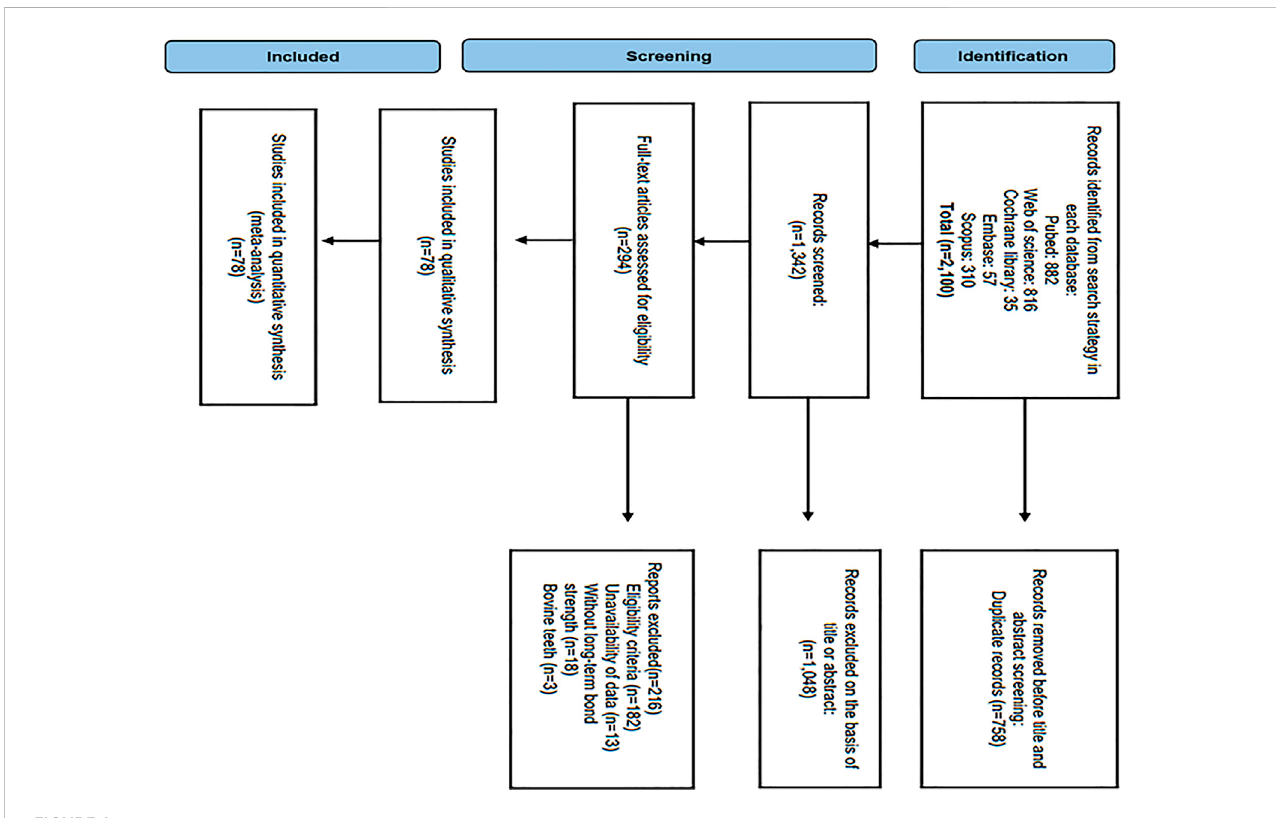
FIGURE 1 PRISMA fl ow chart of study selection.